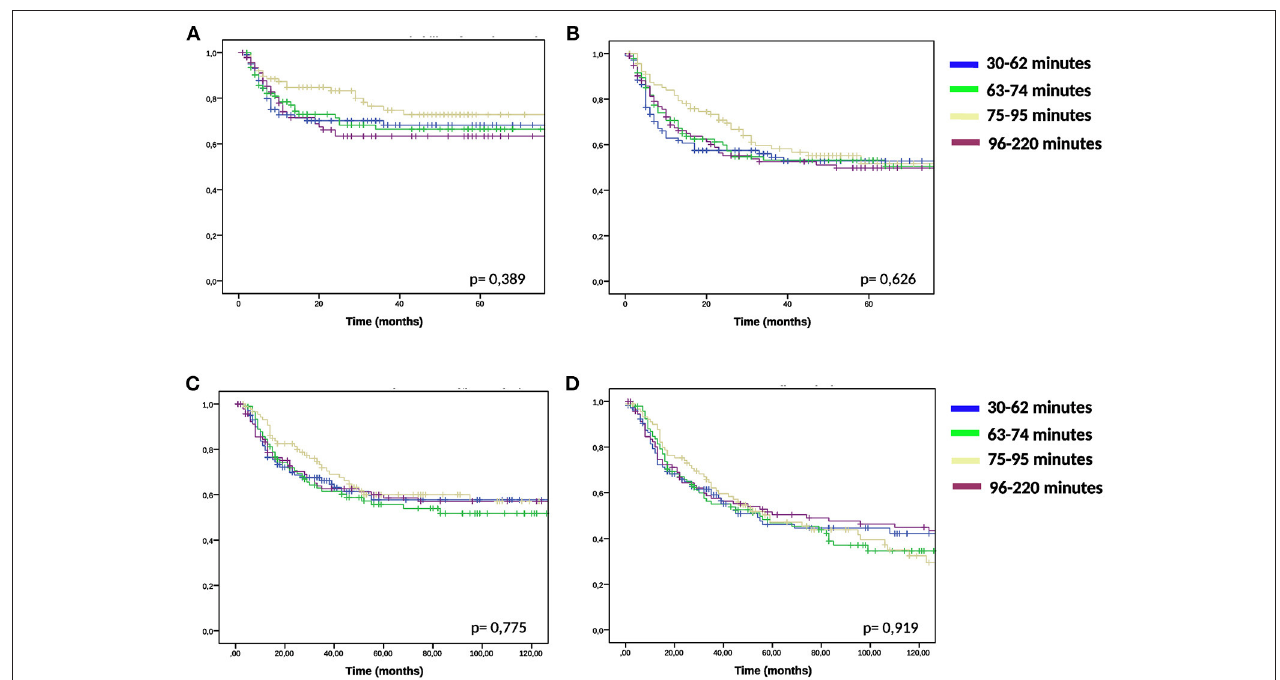
FIGURE 2 | KM analysis of quartile time interval groups. KM-curves for quartiles of the time interval and for LC (A) , DFS (B) , DSS (C), and OS (D) were compared using log-rank